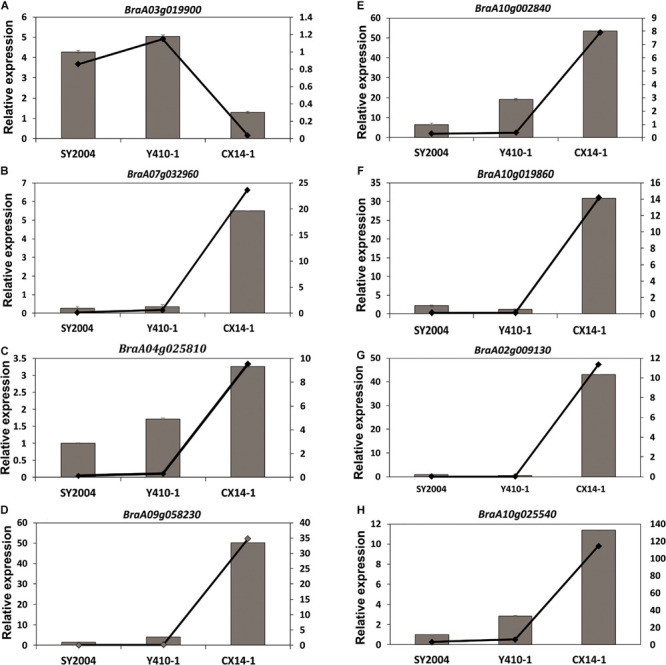
Relative expression of eight unigenes in the floral bud of early- and late-bolting Chinese cabbage double haploid lines. Error bar represents ± SE of the means of triplicates. The superimposed line graph represents the RNA-seq expression profiles [fragments per kilobase of transcript per million fragments mapped (FPKM)].